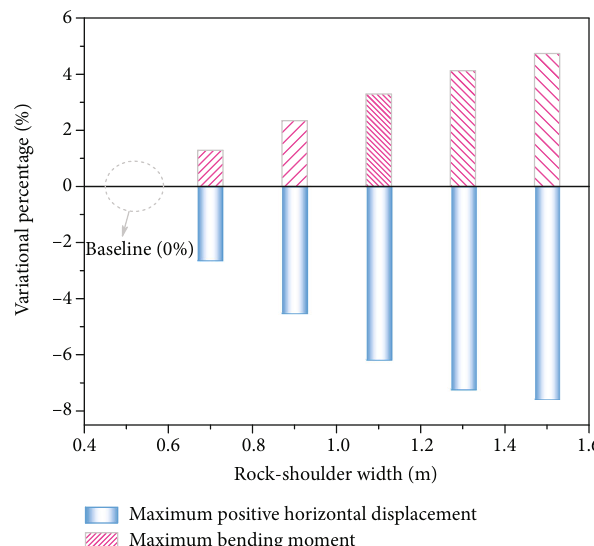
Figure 24: Variations of the maximum positive horizontal displacement and maximum bending moment of the end- suspended pile at di ff erent rock-shoulder